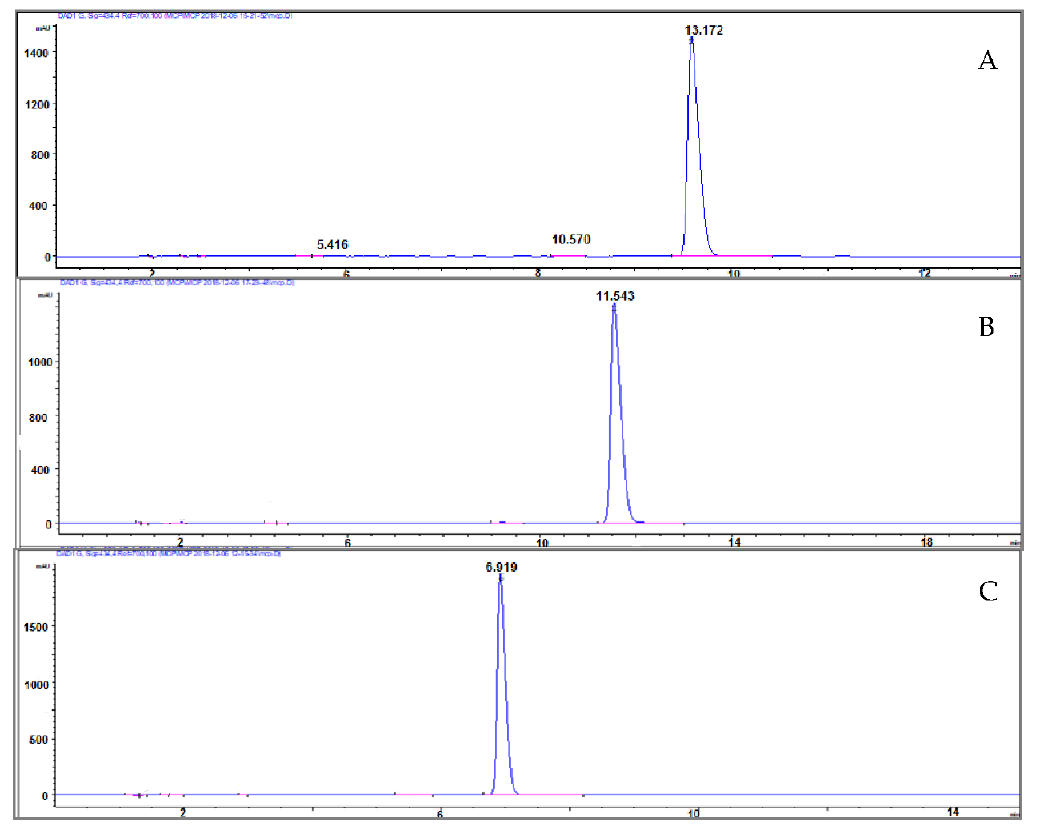
Figure 6. HPLC-DAD chromatogram of 2.5 mM mCP standard solution detected at 434 nm wavelength. Eluent composition: 80% CH 3 COONH 4 and 20% CH 3 CN; pH: ( A ): 7.0, ( B ): 7.5 and ( C ): 8.0.